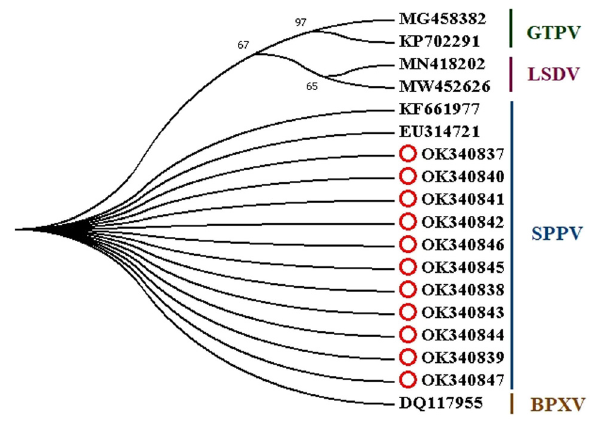
Figure 1: The phylogenetic condensed tree, dressed by the Neighbor - Joining method based on the Tamura 3 - parameter method. The percentages of replicate trees in the bootstrap test ( 1,000 replicates ) are shown next to the branches. The analysis involved 18 nucleotide sequences ( 11 from the current study and 7 from Genbank ) . Evolutionary analyses were conducted in MEGA7.